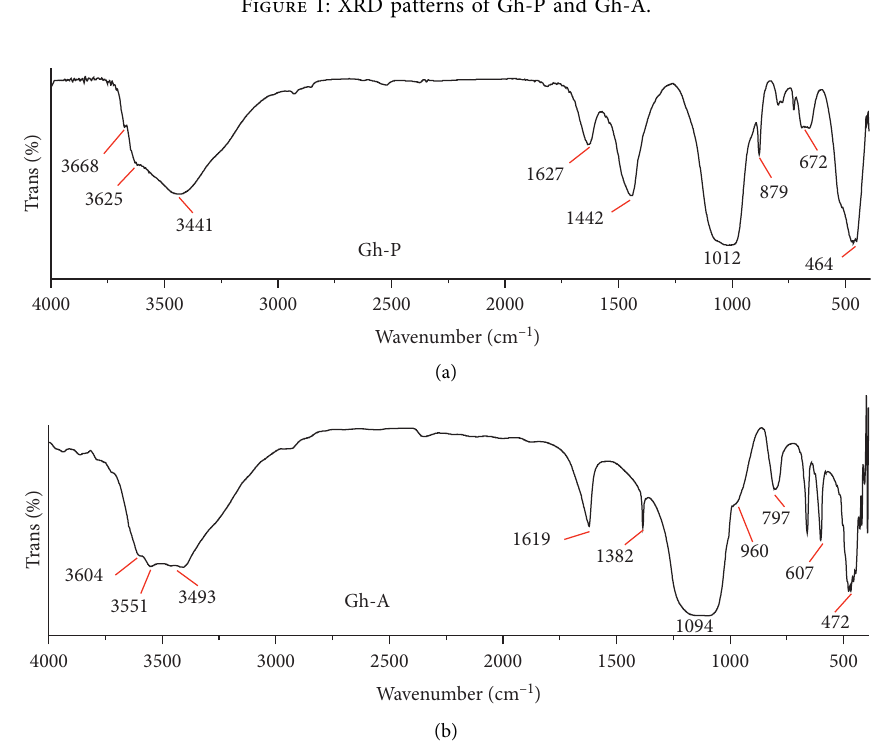
Figure 2: FTIR spectra of Gh-P (a) and Gh-A